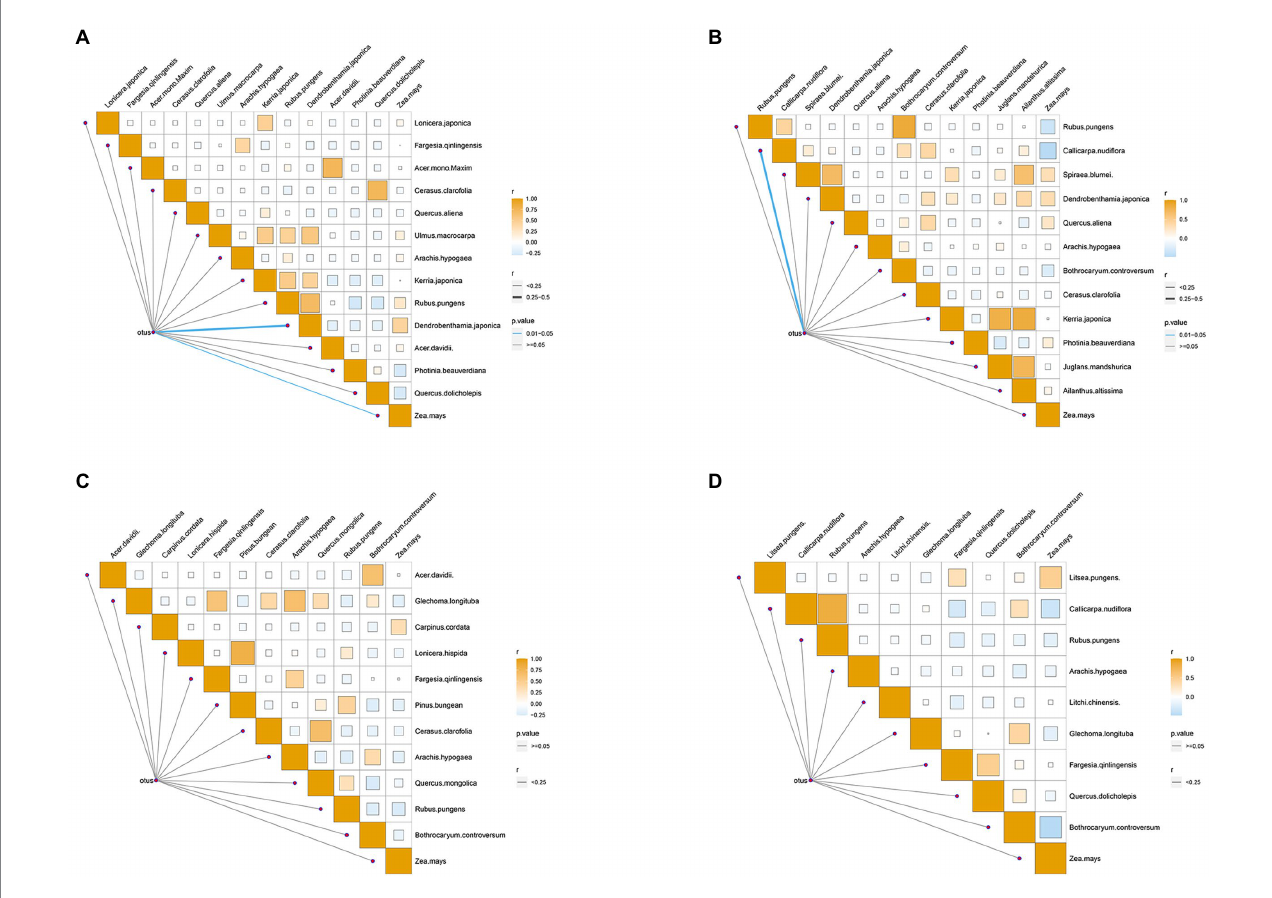
FIGURE 6 Heat map of the correlation between food groups and gut microbes of spring (A) , summer (B) , autumn (C) , winter (D) . Darker color refers to that r value is closer to 1; thicker line refers to higher r value between food groups and gut microbes. The color of the line segment shows the p value between food group and gut microorganism (Blue indicates p value <0.05, grey indicates p value